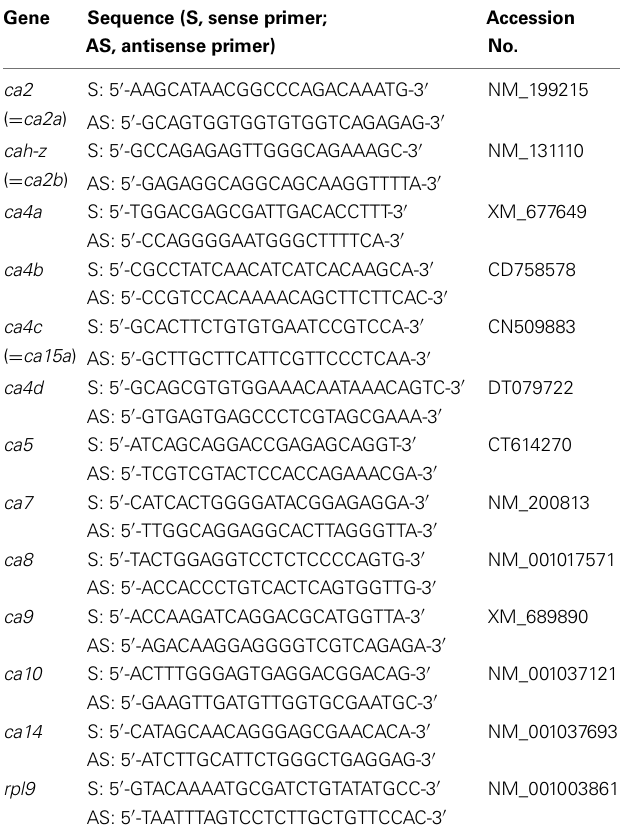
Table 1 | List of primers used for PCR